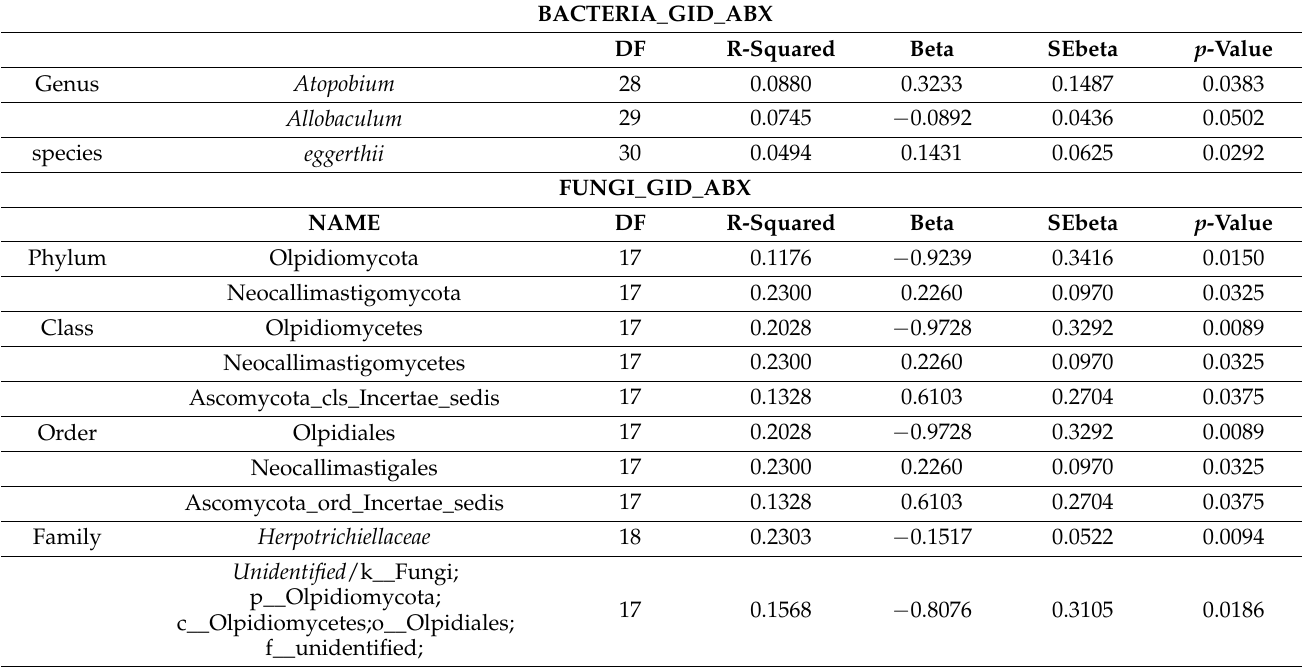
Table 12. Significant changes in bacterial and fungal absolute abundance with ABX exposure in